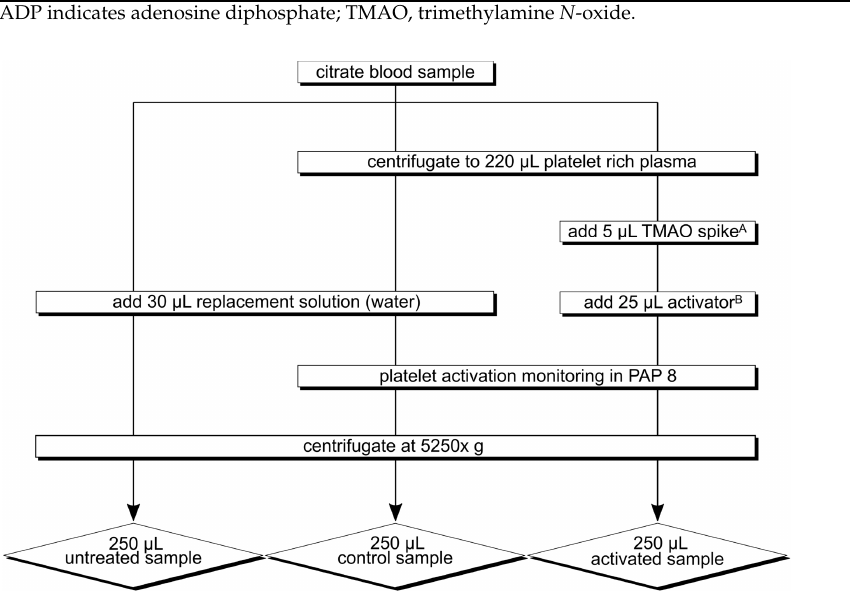
Figure 2. Platelet activation experiment according to Born, experimental setup and sample types. Citrate blood was sampled from healthy participants. TMAO indicates trimethylamine-N-oxide; PAP 8, platelet activation profiler 8. A TMAO solved in water (Target concentration in the sample: 0, 5, 20, or 100 µ mol/L); used in experimental series 3 only. B ADP (5 µ mol/L; used in experimental series 3 only), Ristocetin (1.2